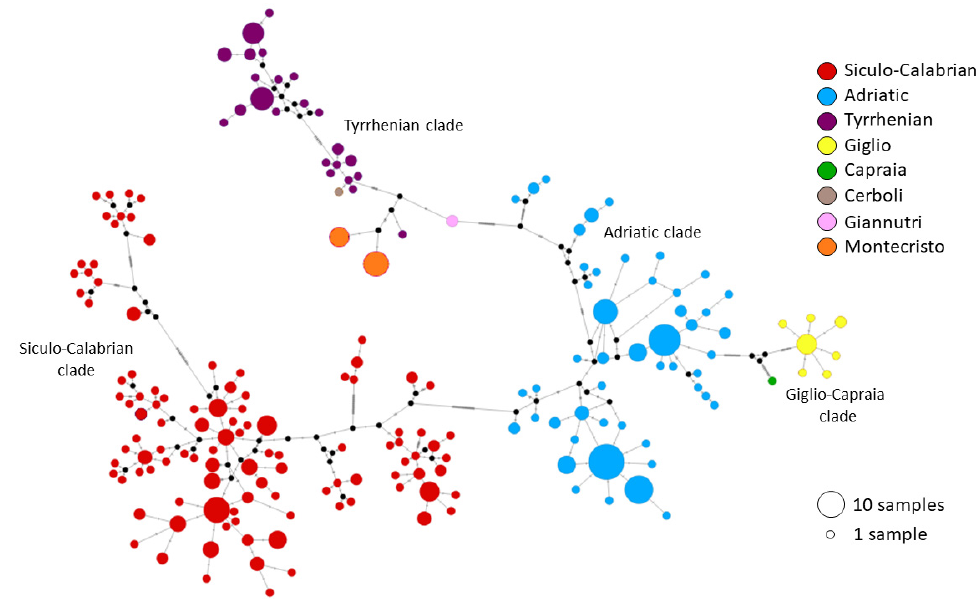
Figure 6. Median joining network built on cytb sequences. Colors represent the three main clades